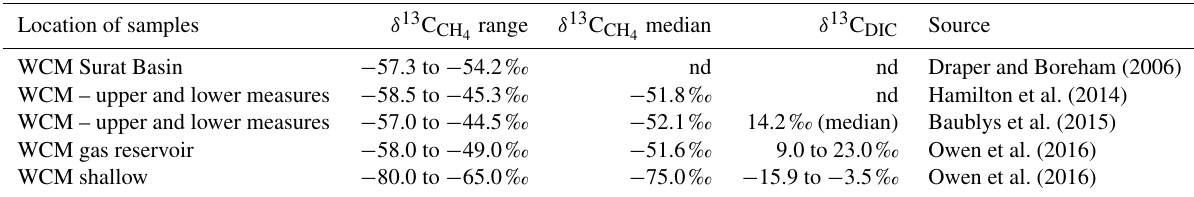
and δ 13 C DIC for the WCM in previous studies. 4